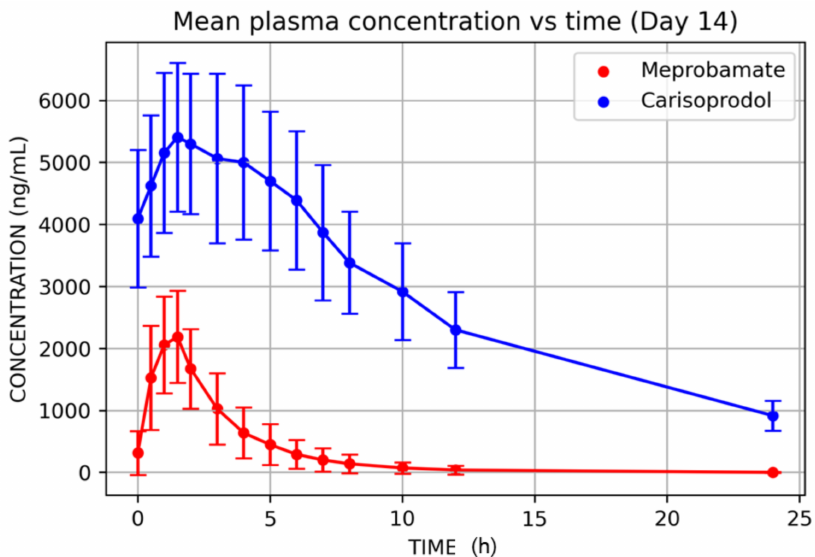
Figure 4. Mean plasma concentrations of carisoprodol and meprobamate after multiple carisoprodol dosing (350 mg/8 h, 14